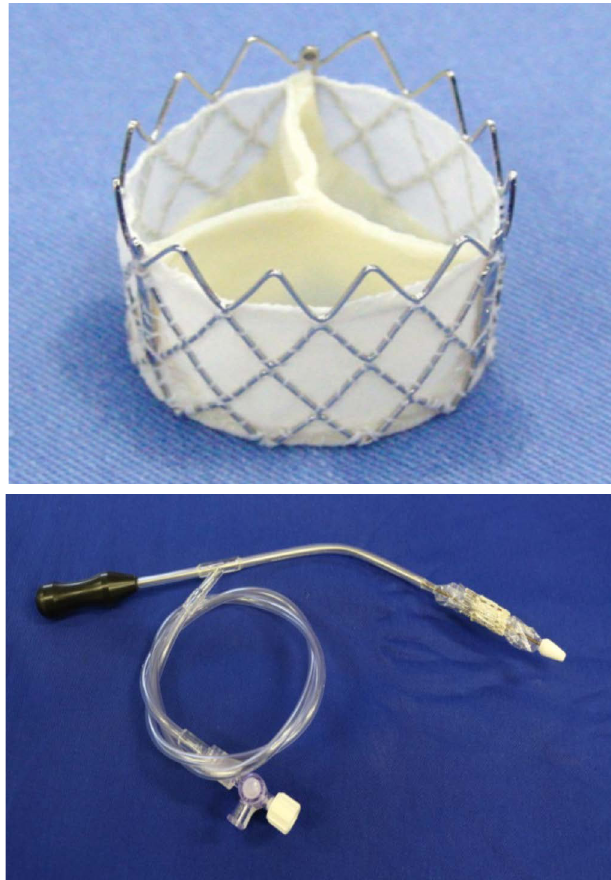
Fig. 1 - The Inovare Alpha sutureless bioprosthesis (above) and the delivery catheter